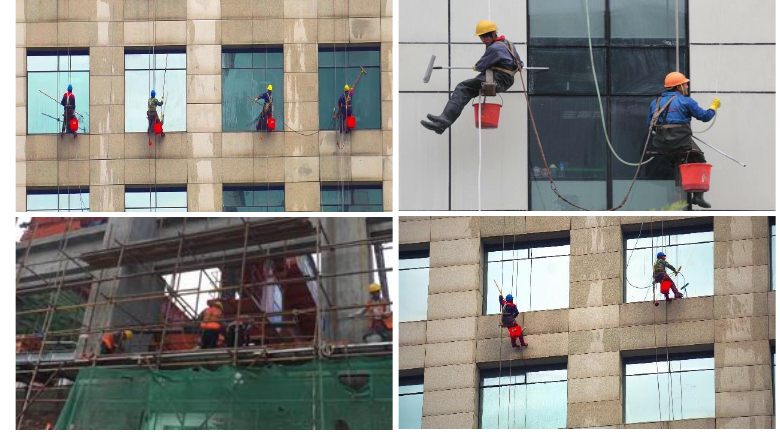
Figure 6. Sample images of our proposed multiobject tracking subdataset.